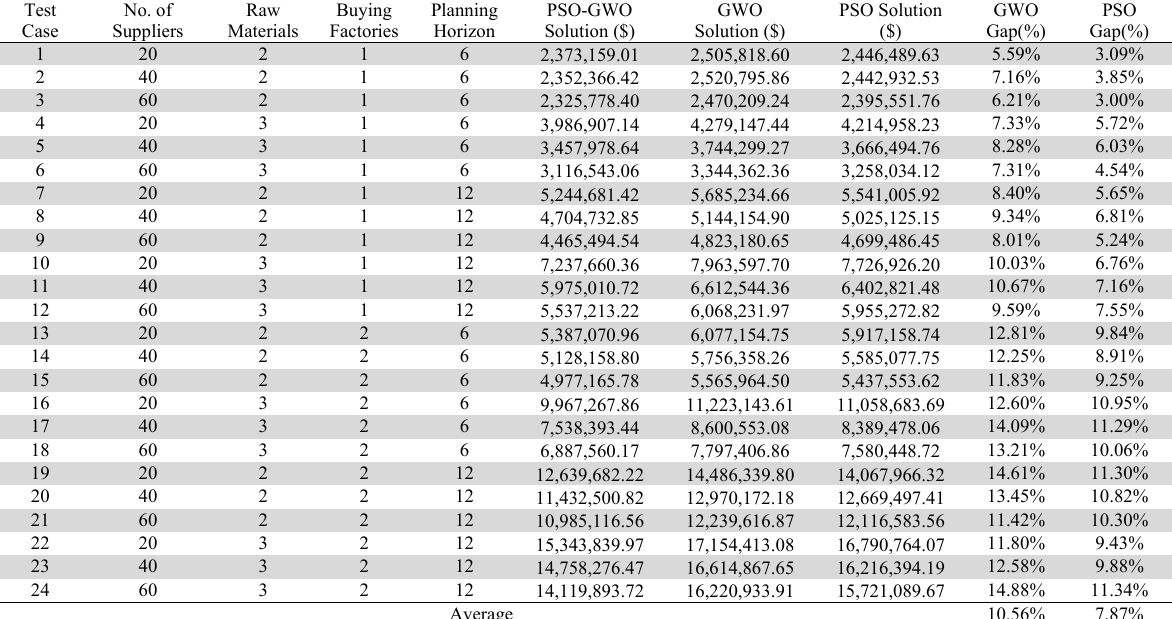
Experimental Results for Large Sized